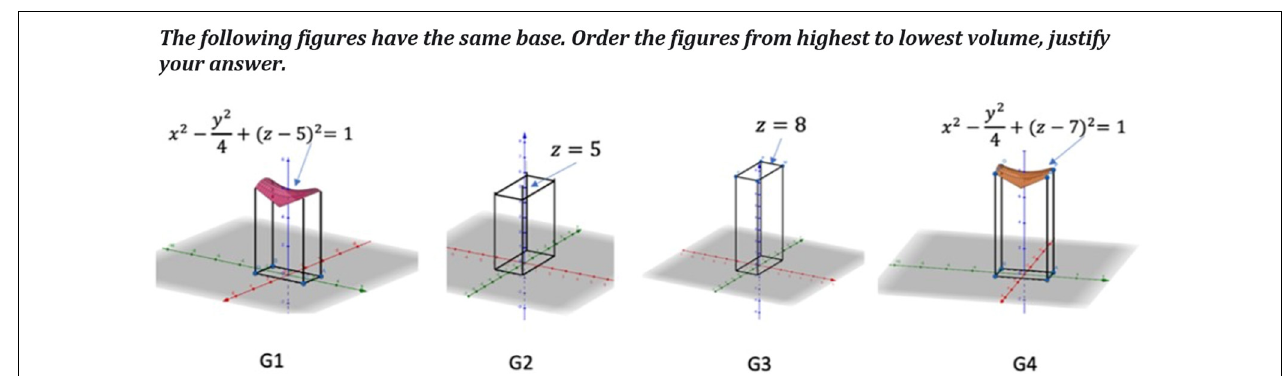
FIGURE 5 | Example of an argumentative question: Order the figures from largest to smallest according to volume. Justify your answer.